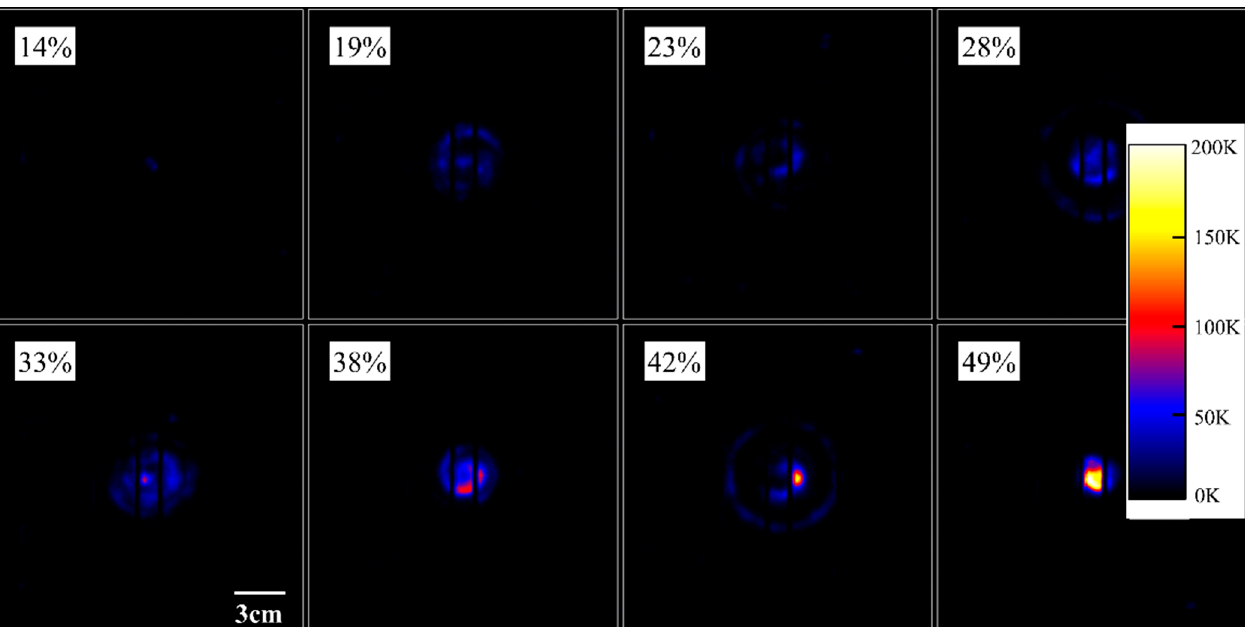
Figure 4. Maps of ∆T (cid:2915)(cid:2927) for gallium-doped PERC cells with a resistivity of 0.4–0.5 Ω cm and a sheet Figure 4. Maps of ∆ T eq for gallium‑doped PERC cells with a resistivity of 0.4–0.5 Ω cm and a sheet resistance of 100 Ω /sq under different resistivity uniformities. resistance of 100 Ω /sq under different resistivity